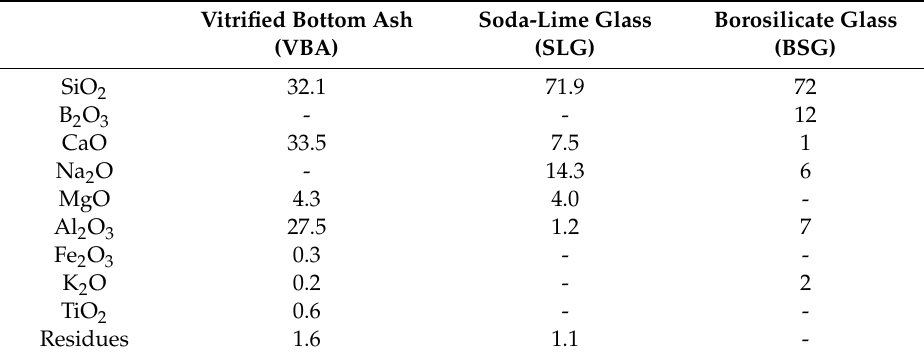
Table 1. Chemical composition (in wt %) of waste streams. Vitrified Bottom